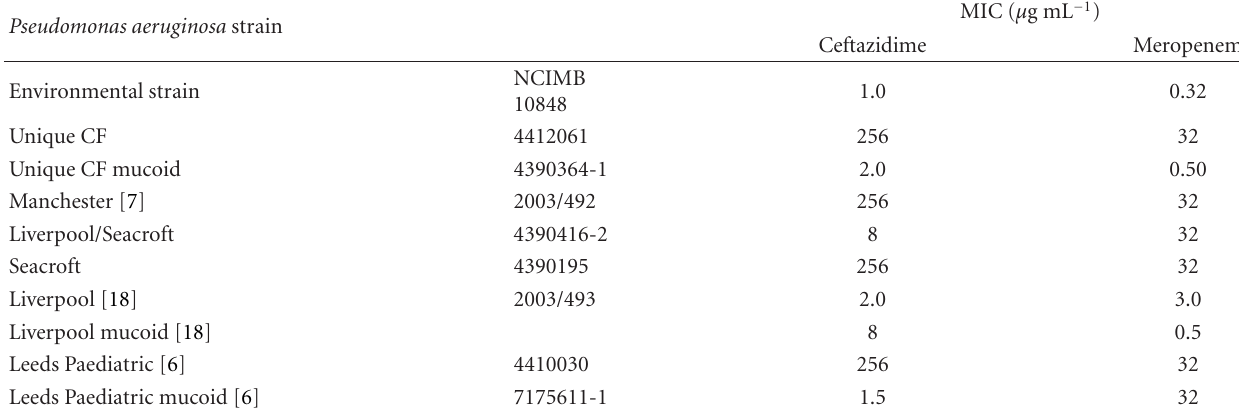
Table 1: Details of Pseudomonas aeruginosa